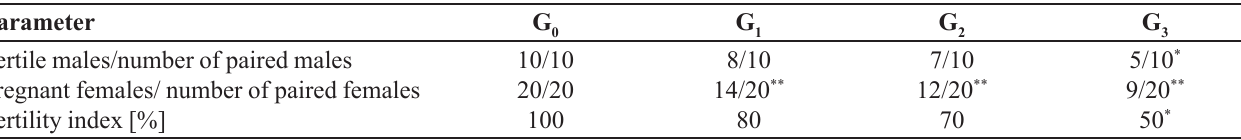
TABLE IV - Parameters related to the male mice reproductive performance Parameter Fertile males/number of paired males Pregnant females/ number of paired females Fertility index